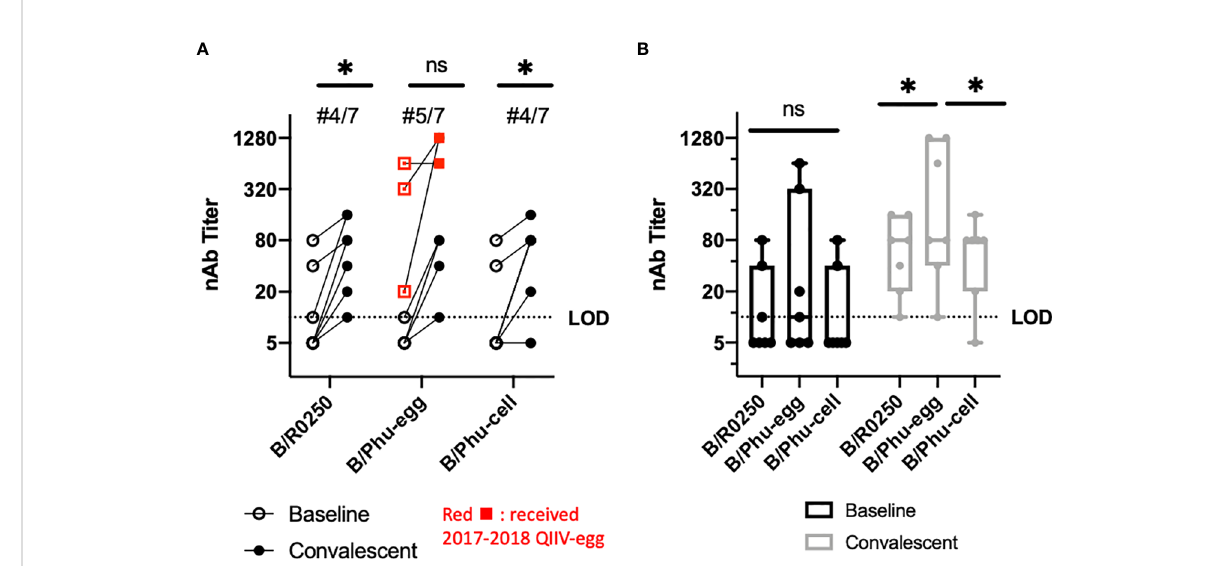
FIGURE 2 Neutralizing Antibody Assays-IBV infected individuals from 2017-2018 Season. 7 patients with natural IBV infection (B/Yamagata lineage) at Johns Hopkins Hospital had serum samples collected during active infection (baseline) and 4-6 weeks following infection (convalescent). B/ Baltimore/R0250/2018 (B/R0250), B/Phuket/3073/2013-egg cultured (B/Phu-egg) and B/Phuket/3073/2013-cell cultured (B/Phu-cell) were used for comparison. (A) Matched values during (baseline) and 4-6 weeks (convalescent) after natural infection with B/Yamagata lineage in fl uenza viruses. Participants shown in red received the egg grown quadrivalent vaccine that season. Paired T-test used to calculate signi fi cance (B) Box and Whisker plot comparing median nAb titers during (baseline) and 4-6 weeks after (convalescent) natural infection in our comparison viruses. Two-way Anova with multiple comparisons was used to calculate statistical signi fi cance of median values. An * indicates p<0.05 and ns indicates a not signi fi cant